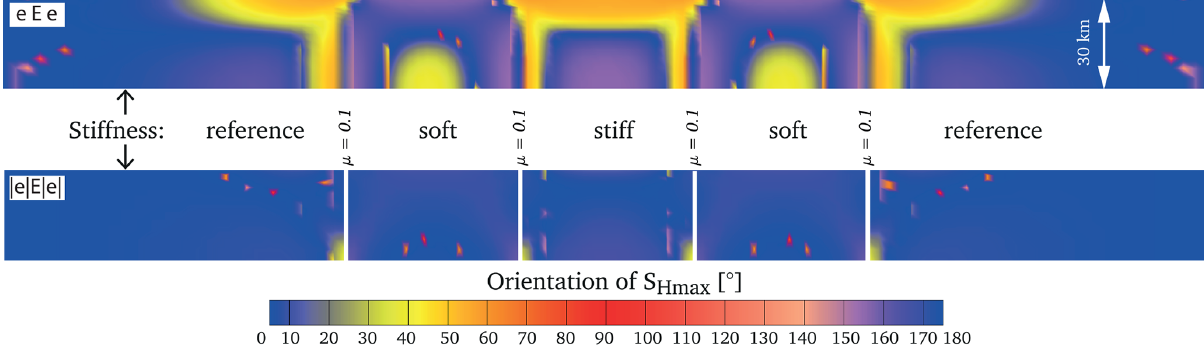
Figure 12. North–south depth profiles displaying the S Hmax orientation colour-coded for models with a variable Young’s modulus. In the model without the discontinuities (eEe), S Hmax is oriented around 40 ◦ in the stiffer units next to the softer units near the Earth surface. A similar orientation can be observed in the soft units in the deepest parts. In contrast to that, in the model with the same material properties but low-friction faults ( | e | E | e | ), the S Hmax orientation is nearly north–south for all units and depths. (Small coloured dots are artefacts.) The discontinuities with a low-friction coefficient counterbalance stress rotation due to the stiffness